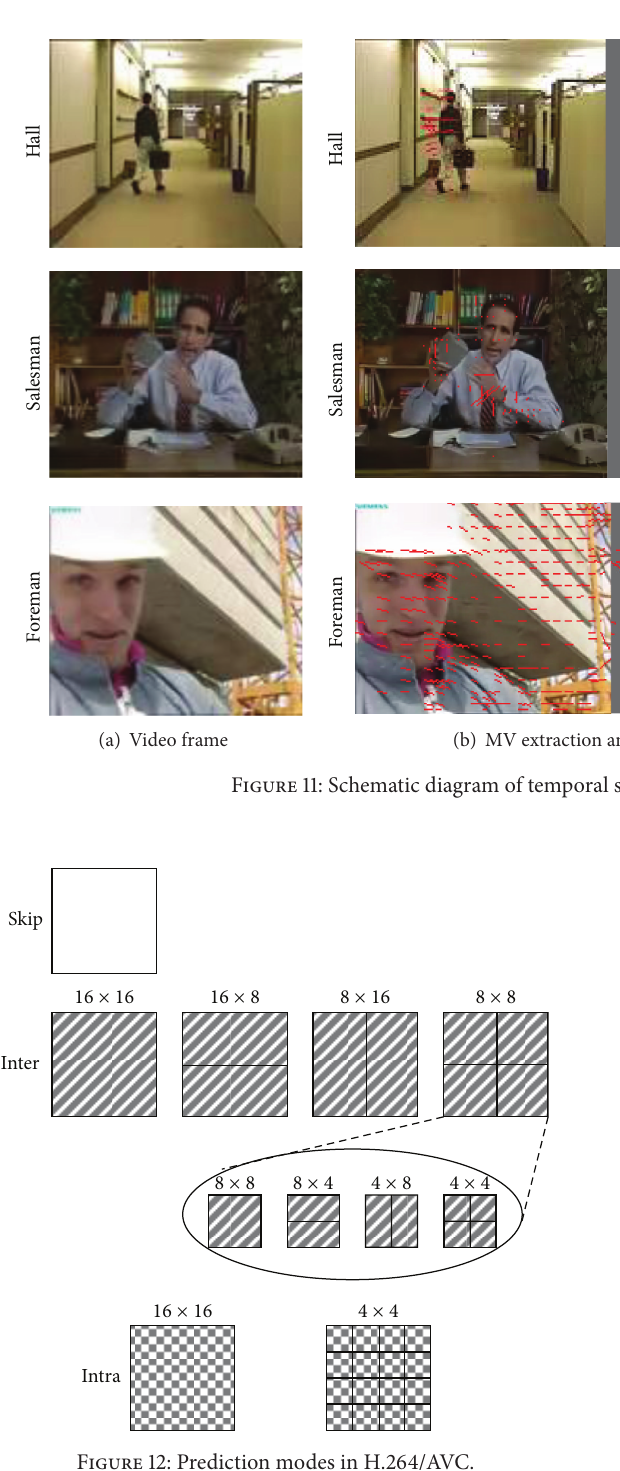
there appears new information or the encoding content is varied greatly in current frame compared with previous frame. It can be found that, in Figure 13(d), there are 6 MBs (with red dots mark) which select Intra 4 × 4 as the opti- mal prediction mode; because the woman raised right